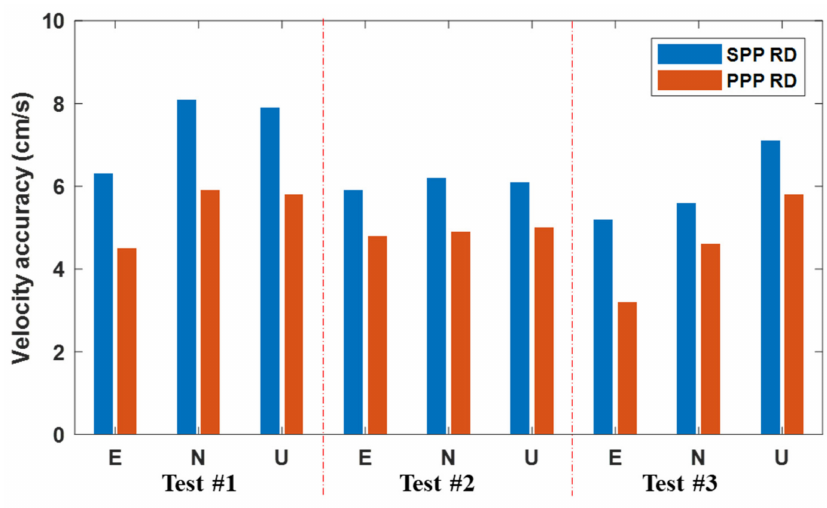
Figure 9. Velocity accruracy comparison between the PPP and SPP